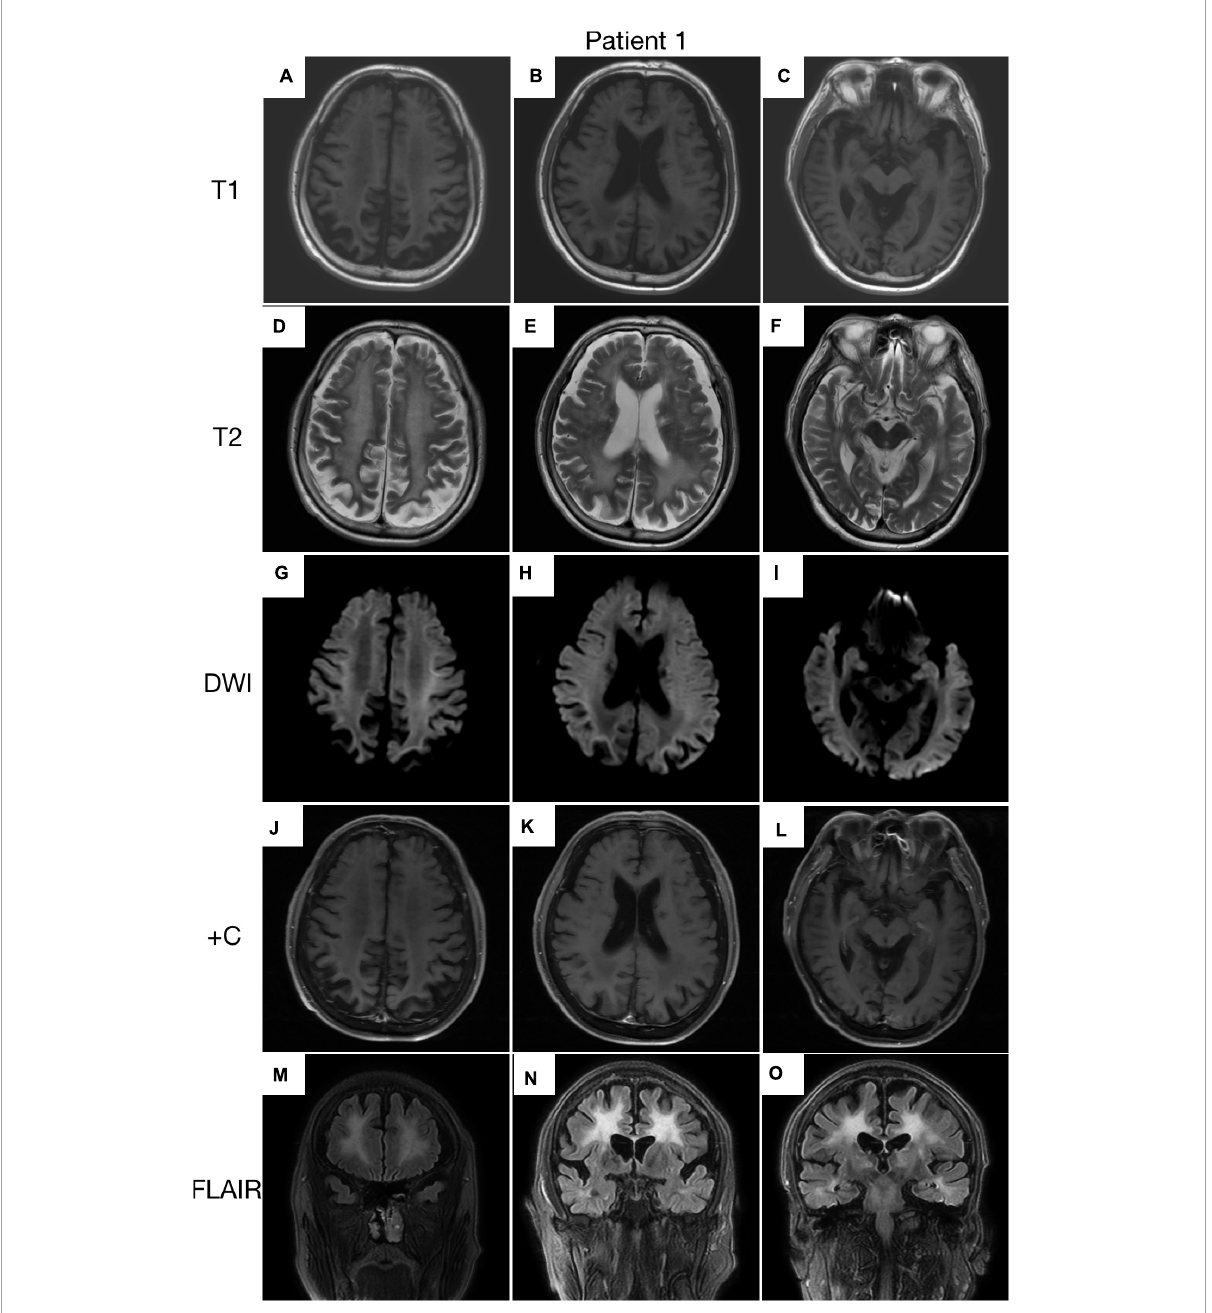
FIGURE1 Brain MRI scan of patient 1. Cerebral atrophy was observed on T1 images (A–C) . T2 (D–F) and FLAIR (M–O) images showed severe leukoencephalopathy. Diffusion-weighted imaging (DWI) images revealed high linear signal in the corticomedullary junction (G–I) . No significant enhancing lesions were observed (J–L)